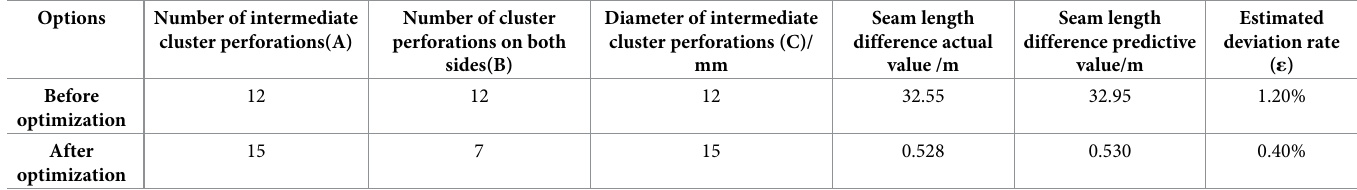
Table 5. Evaluation table of perforation parameters before and after optimization.